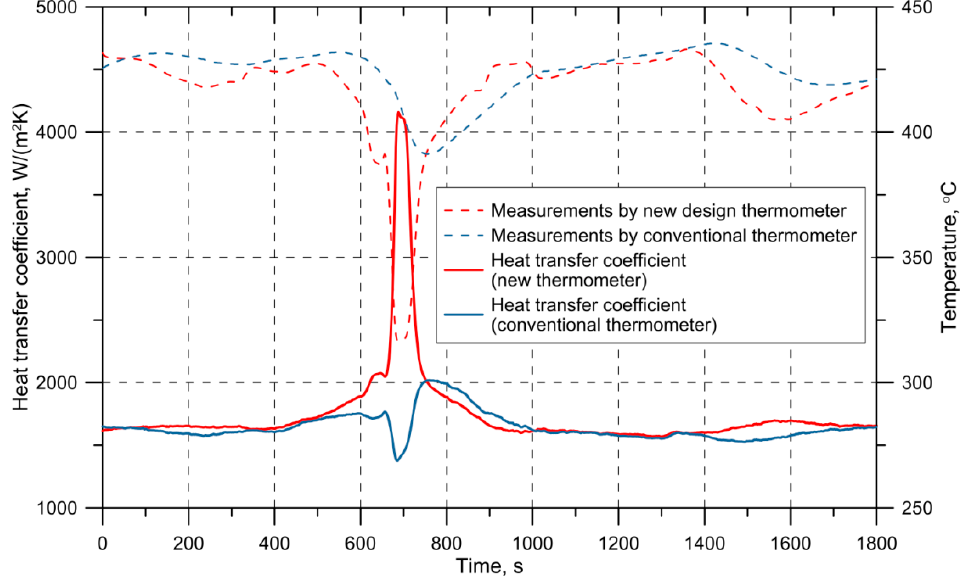
Figure 14. Heat transfer coefficient on the inner surface of the header determined using a new thermometer and standard thermometer measurements as functions of time.